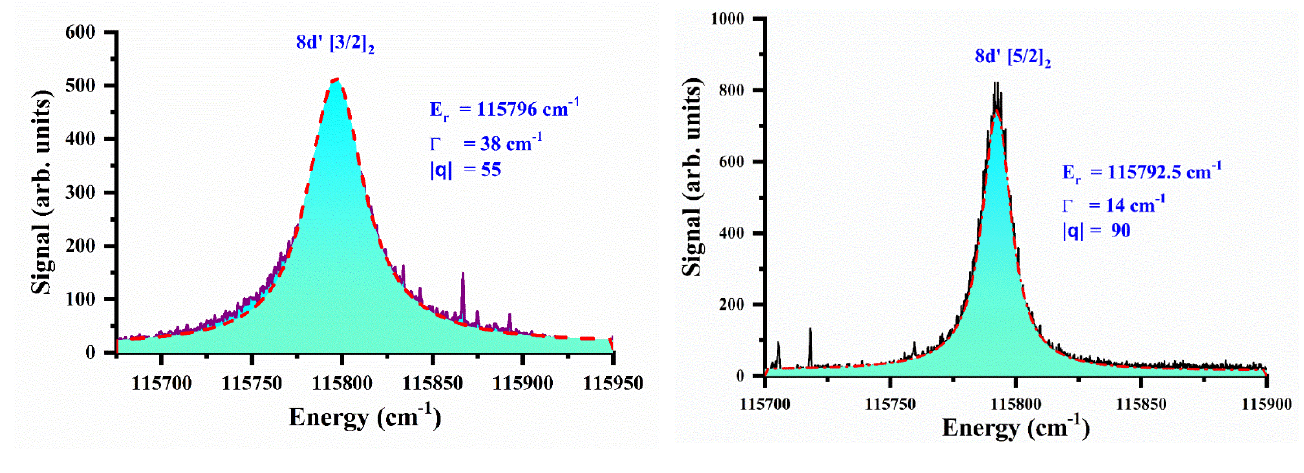
ns J = 1 and nd J = 1 states and multiphoton excitation of odd or even Rydberg states by